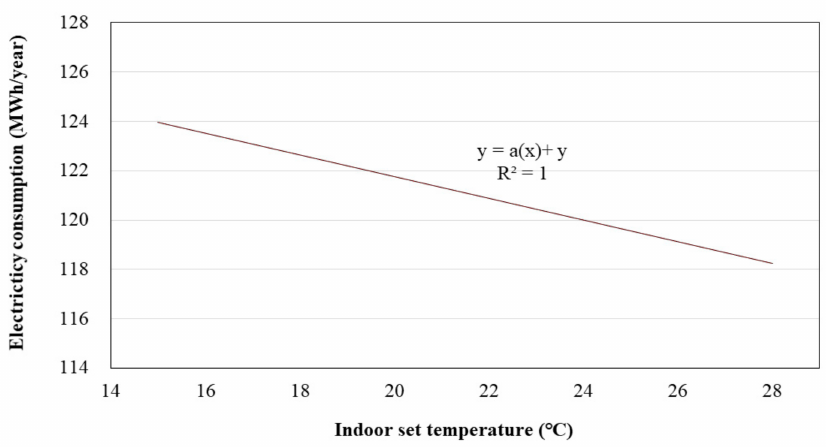
Figure 12. Variation in the annual electricity consumption with the indoor set